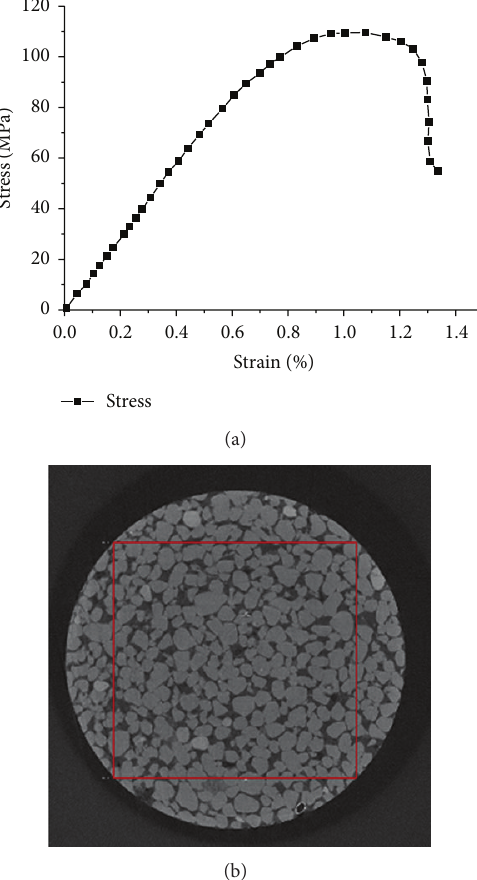
Figure 2: Basic data for rock mechanics experiment and CT imaging. (a) is stress-strain curve; (b) is cross-section image of sandstone sample